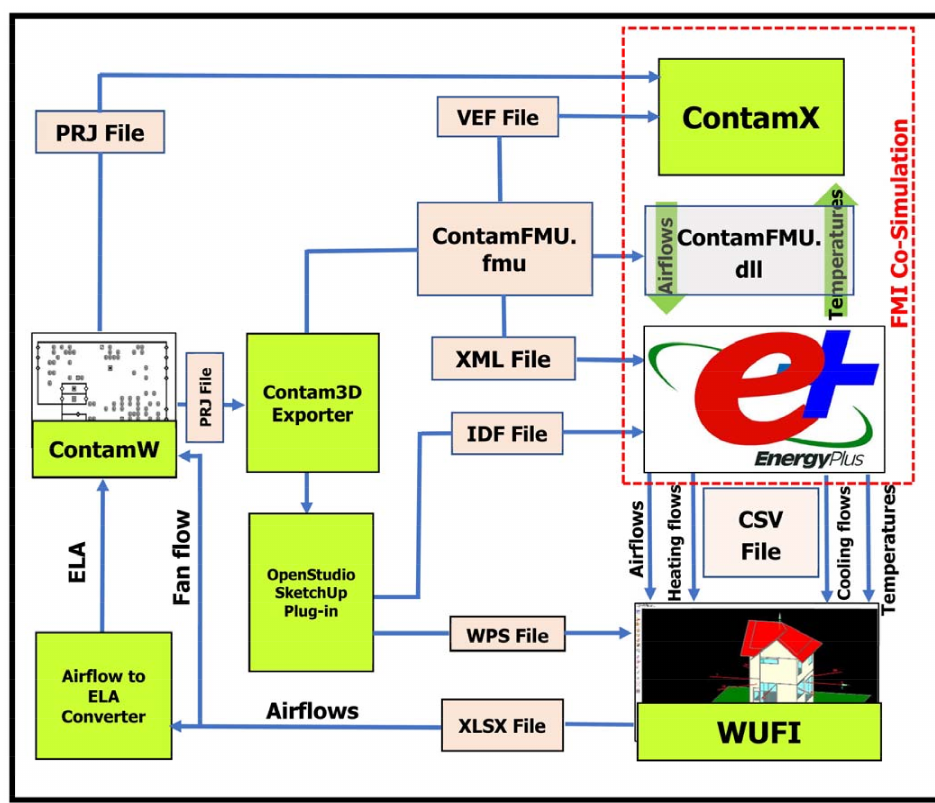
Figure 1. Combination mechanism for EnergyPlus, CONTAM, and WUFI. DLL: dynamic link library, VEF: variable exchange file, FMI: functional mock-up interface, FMU: functional mock-up